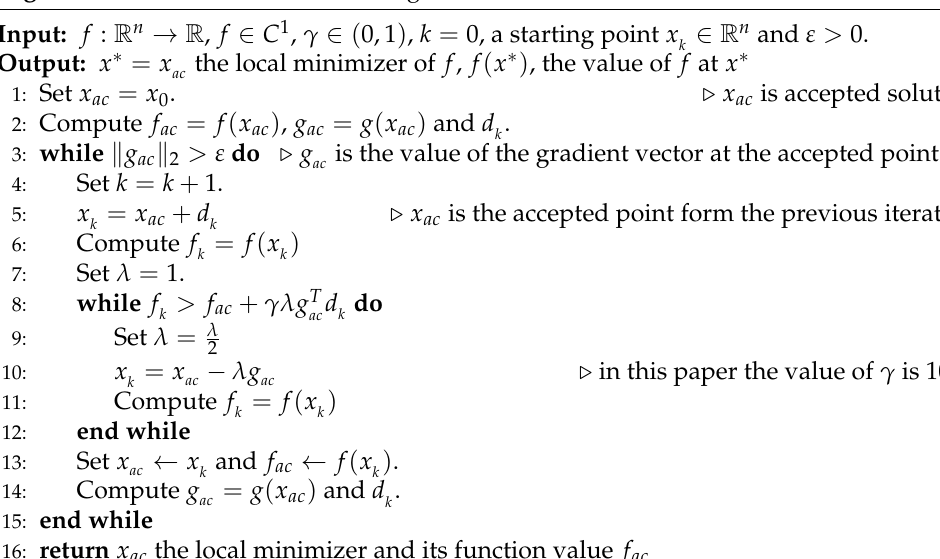
Algorithm 1 Line-Search Gradient Algorithm